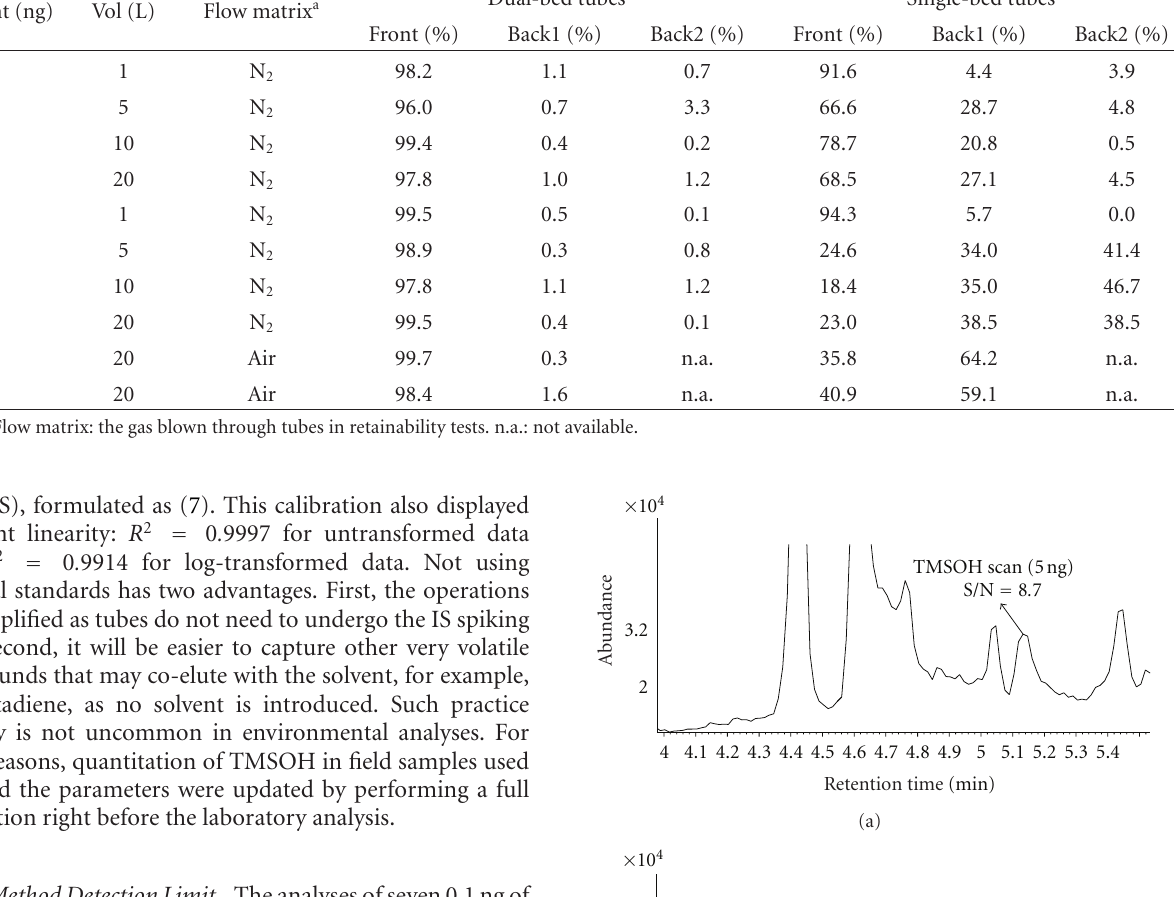
Table 2: Results of retainability tests. Front, Back1, and Back2 were the front, 1st backup and 2nd backup tubes in series. Amounts of TMSOH in three tubes were expressed as the percentages of the initial amount spiked to the front tube. Dual-bed tubes Single-bed tubes Amount (ng) Vol (L) Flow matrix a Front (%) Back1 (%) Back2 (%) Front (%) Back1 (%) Back2 (%)